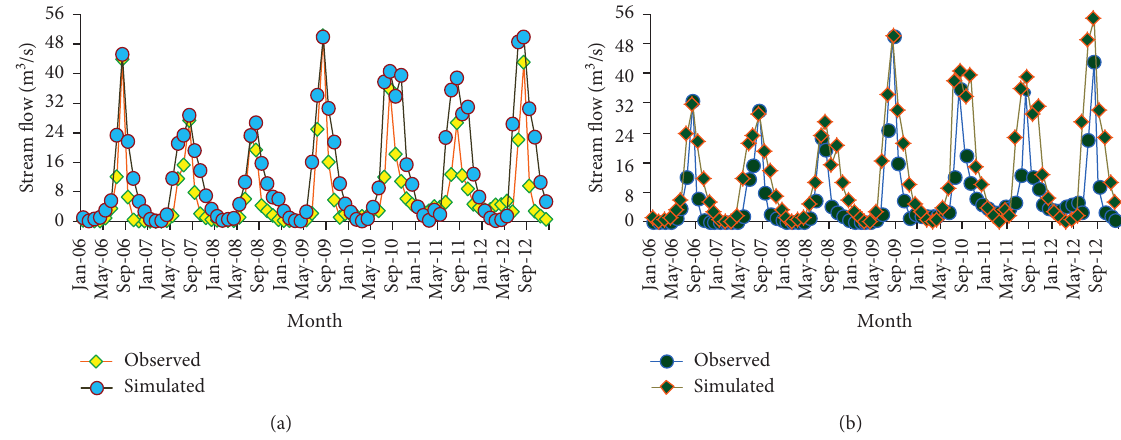
Figure 12: Stream flow comparison for calibration periods (a) 1998 LULC and (b) 2016 LULC. Table 7: Calibrated values for 1998 historical LULC. Rank Flow parameters